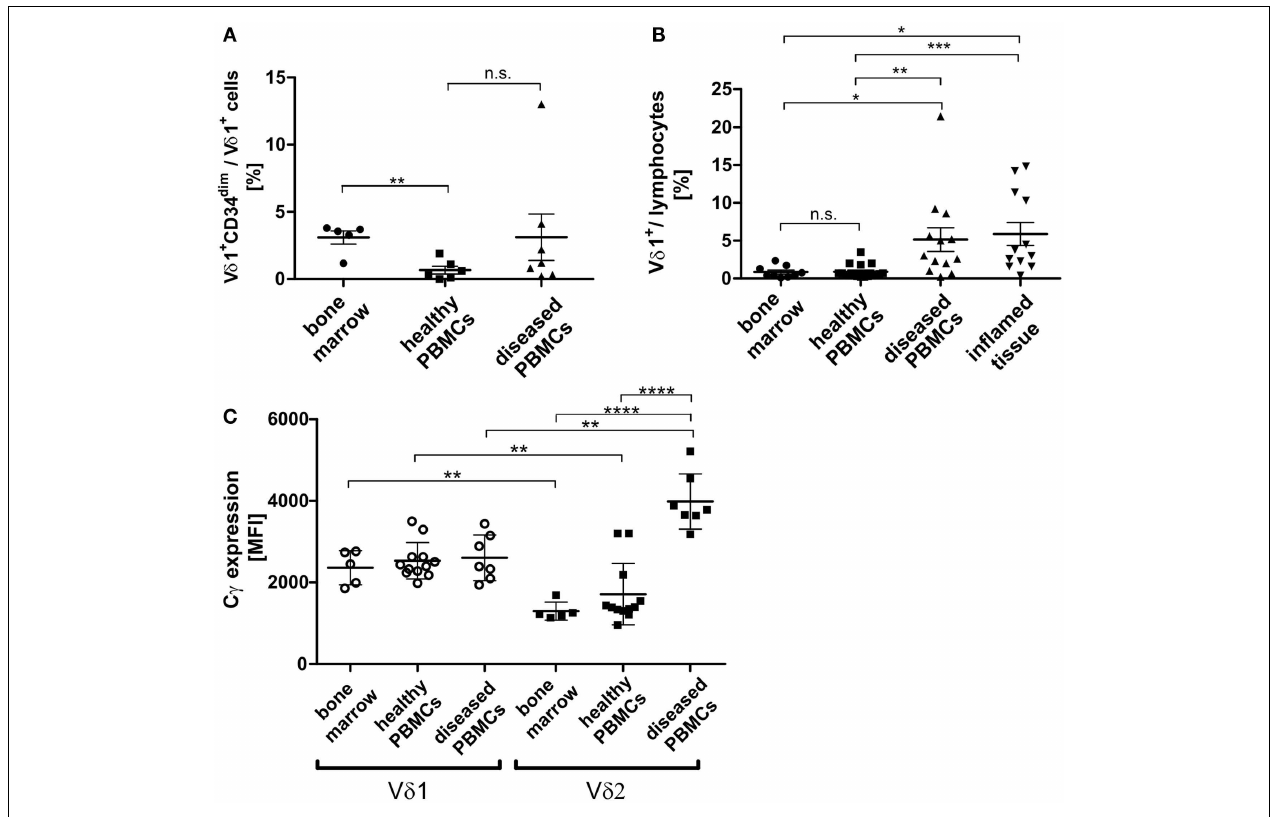
0.89 ± 0.22 SEM).V δ 1 + lymphocytes were significantly more frequent in peripheral blood ( p = 0.0367) and body fluids ( p = 0.0107) of diseased individuals than in bone marrow ( n = 9 mean: 0.85 ± 0.26 SEM). (C) Absolute expression level ofTCR- γ chain onV δ 1 + andV δ 2 + cells in healthy ( n = 12) and diseased ( n = 7) peripheral blood and bone marrow ( n = 5). Blood samples included blood from patients with uncharacterized viral infection ( n = 3), pneumonia ( n = 1), cystitis ( n = 2), nephritis ( n = 1) (C γ MFI mean:V δ 1 bonemarrow 2360 ± 188 SEM versusV δ 2 bonemarrow 1298 ± 99 SEM; V δ 1 healthy 2533 ± 129 SEM versusV δ 2 healthy 1711 ± 218SEM;V δ 1 diseased 2606 ± 213SEM versusV δ 2 diseased 3986 ± 256